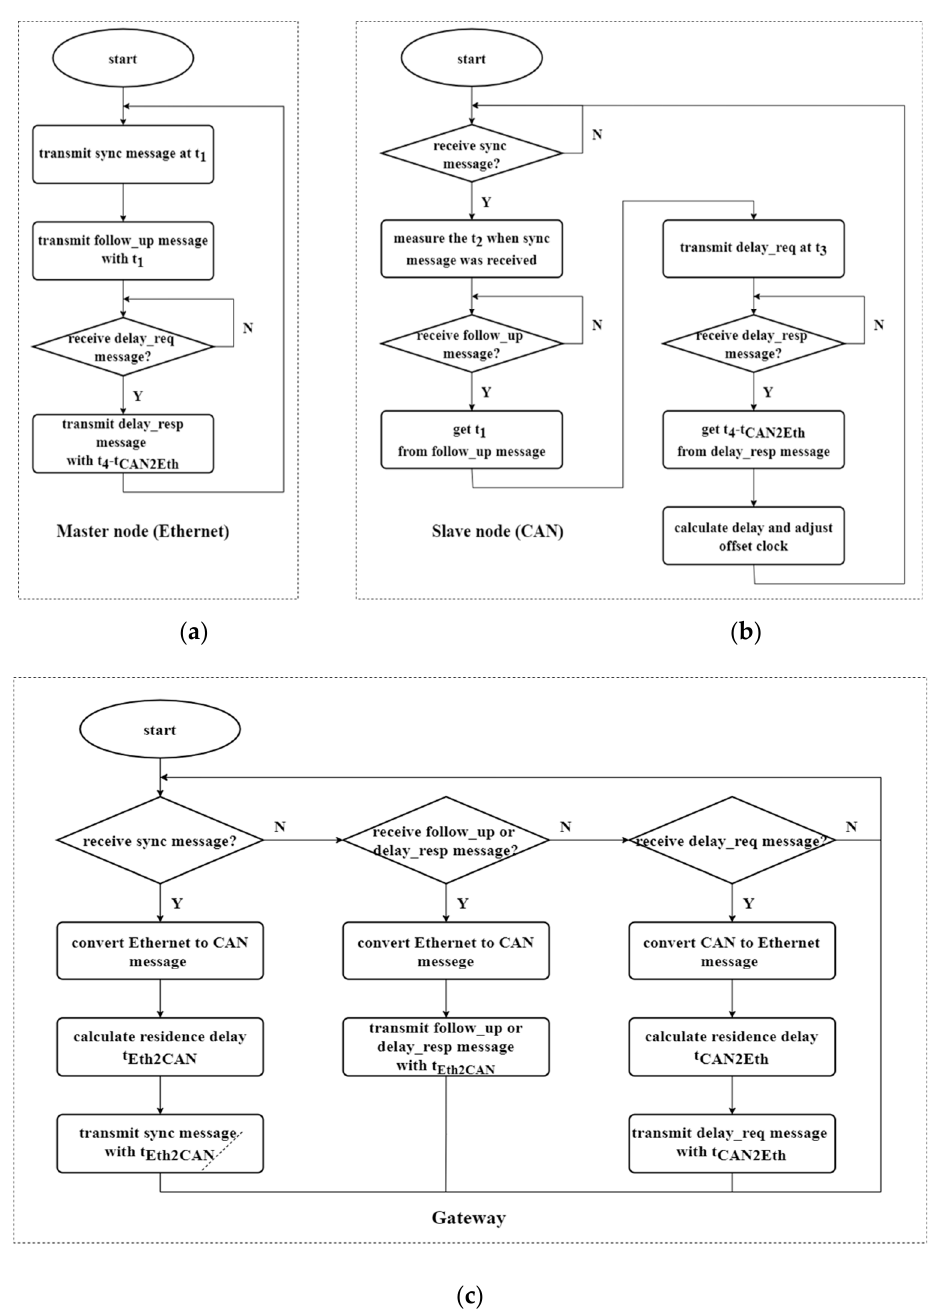
Figure 4. Synchronization algorithm of the master and slave nodes in the CAN–Ethernet network: ( a ) master node (Ethernet), ( b ) slave node (CAN), and ( c ) gateway.